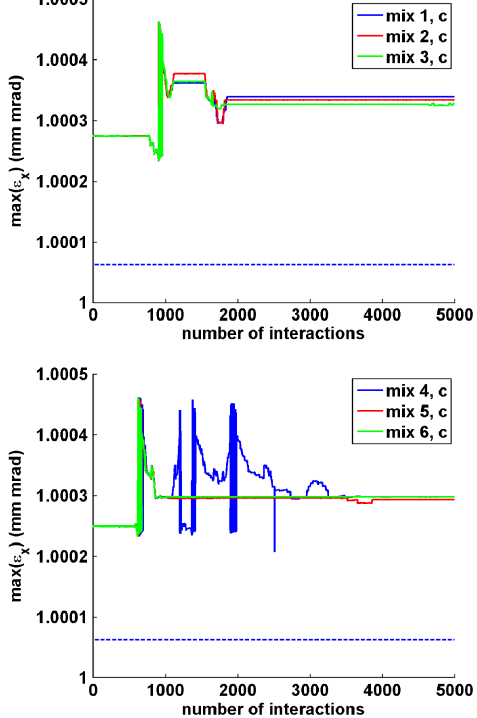
FIG. 12. Maximal emittance of a bunch after interaction with different composition of ion clouds in a circular beam pipe. The dotted line indicates the designed emittance.